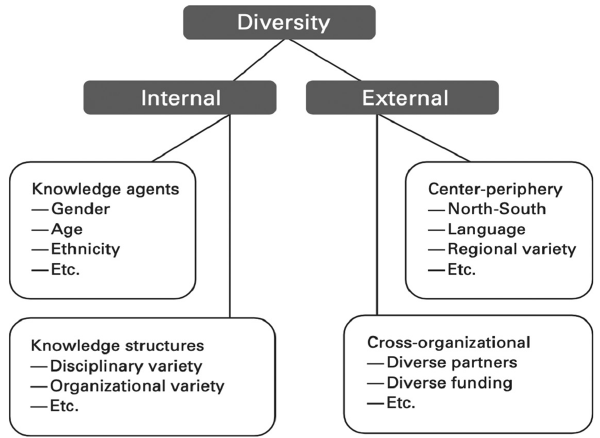
Fig. 4: Dimensions of diversity in open knowledge institutions. Source: Montgomery et al.